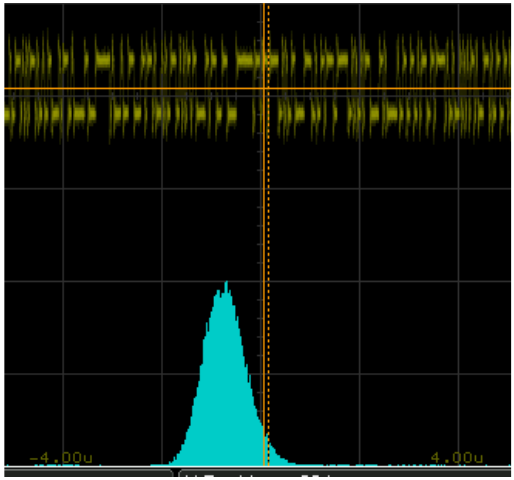
Figure 3. Evidence of Gaussian jitter captured by the digital oscilloscope from the TRNG implemented on an FPGA.